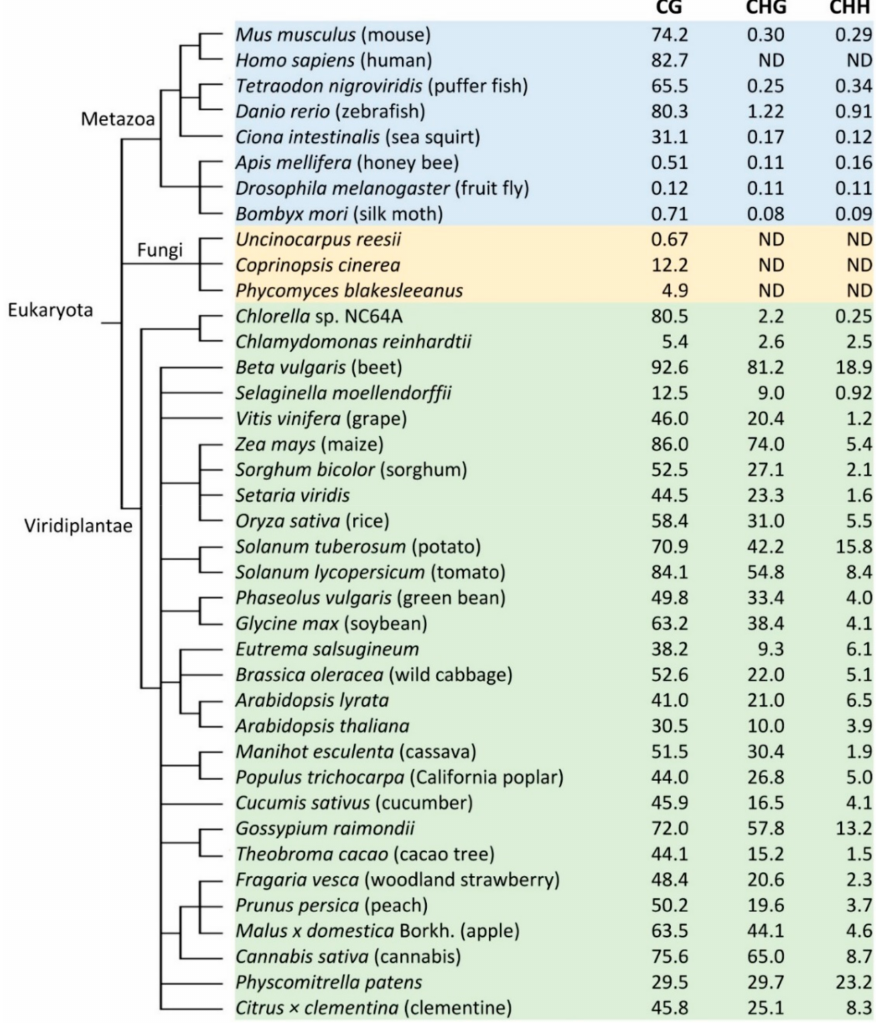
Figure 1. DNA methylation levels in 39 eukaryotic organisms. Although the methylation data were from different studies, and in different organs or tissues that might have some technical variations among different experiments, all of these were from recent methylome research, and procedures and technologies used were similar, including genomic library construction, bisulfite conversion and efficiency, and next-generation sequencing. Taxonomy was obtained from the National Center for Biotechnology Information (NCBI) (https://www.ncbi.nlm.nih.gov/taxonomy). Species, materials and methylation data in Figure 1 were from references listed below: M. musculus , E13.5 embryos from strain C57BL/6J [45]; H. sapiens , H1 human embryonic stem cells [46]; T. nigroviridis , whole fish [44]; D. rerio , 5-day-old embryos [45]; C. intestinalis , Ciona animals collected from Half Moon Bay, CA [45]; A. mellifera , whole adult workers [44]; D. melanogaster , embryo 0–3 h [44]; B. mori , whole larvae [44]; U. reesii , mycelium [44]; C. cinereal , mycelium of strain Okayama 7 [44]; P. blakesleeanus , mycelium of strain NRRL 1555 [44]; Chlorella sp. NC64A, cells cultured in medium [44]; C. reinhardtii , vegetative cells from strain CC503 [45]; B. vulgaris , leaf [41]; S. moellendorffii , aerial tissues of adult soil plants [44]; V. vinifera , leaf [41]; Z. mays , kernel [47]; S. bicolor , leaf [41]; S. viridis , leaf [41]; O. sativa , leaf [41]; S. tuberosum , tuber tissue [48]; S. lycopersicum , leaf [41]; P. vulgaris , leaf [41]; G. max , fully expanded leaf [39]; E. salsugineum , leaf [41]; B. oleracea , leaf [41]; A. lyrate , leaf [41]; A. thaliana , leaf [41]; M. esculenta , leaf [41]; P. trichocarpa , leaf [41]; C. sativus , leaf [41]; G. raimondii , leaf [41]; T. cacao , leaf [41]; F. vesca , leaf [41]; P. persica , leaf [41]; M. domestica , leaf [41]; C. sativa , leaf [41]; P. patens , whole plants growing on plates [44]; C. clementine , leaf [41]. ND, not